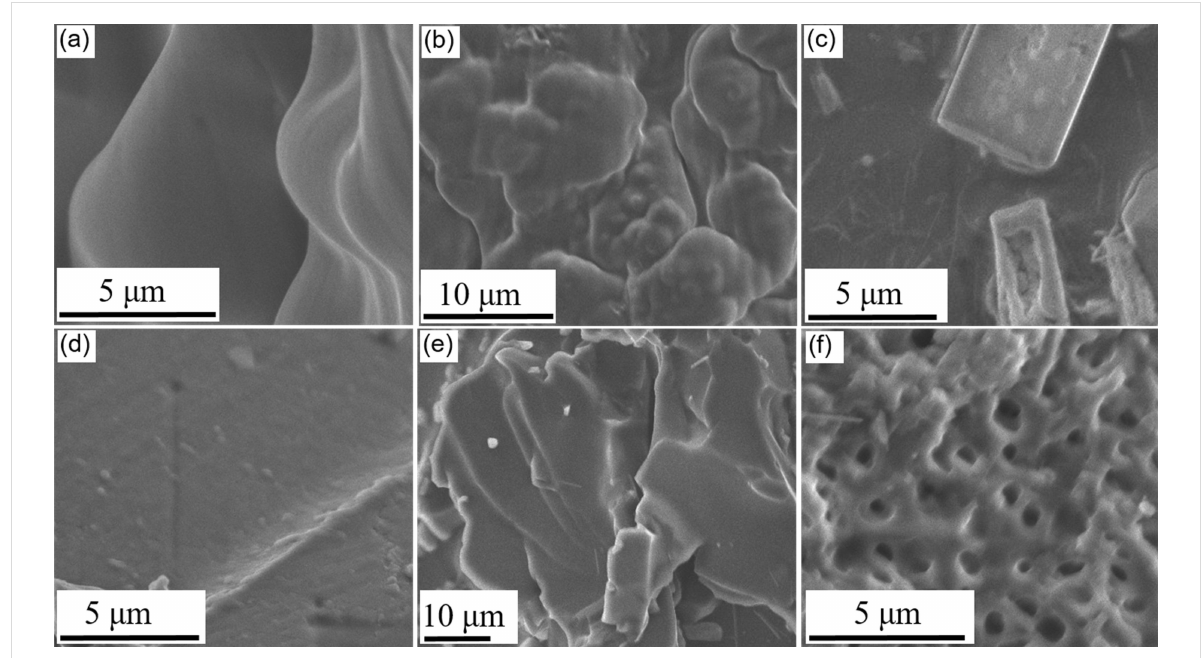
Figure 3: SEM images of pHEMA hydrogel samples synthesized using different quantities of DI water. (a) 1 mL, (b) 1.1 mL, (c) 1.2 mL, (d) 1.3 mL, (e) 1.4 mL, and (f) 1.5 mL.